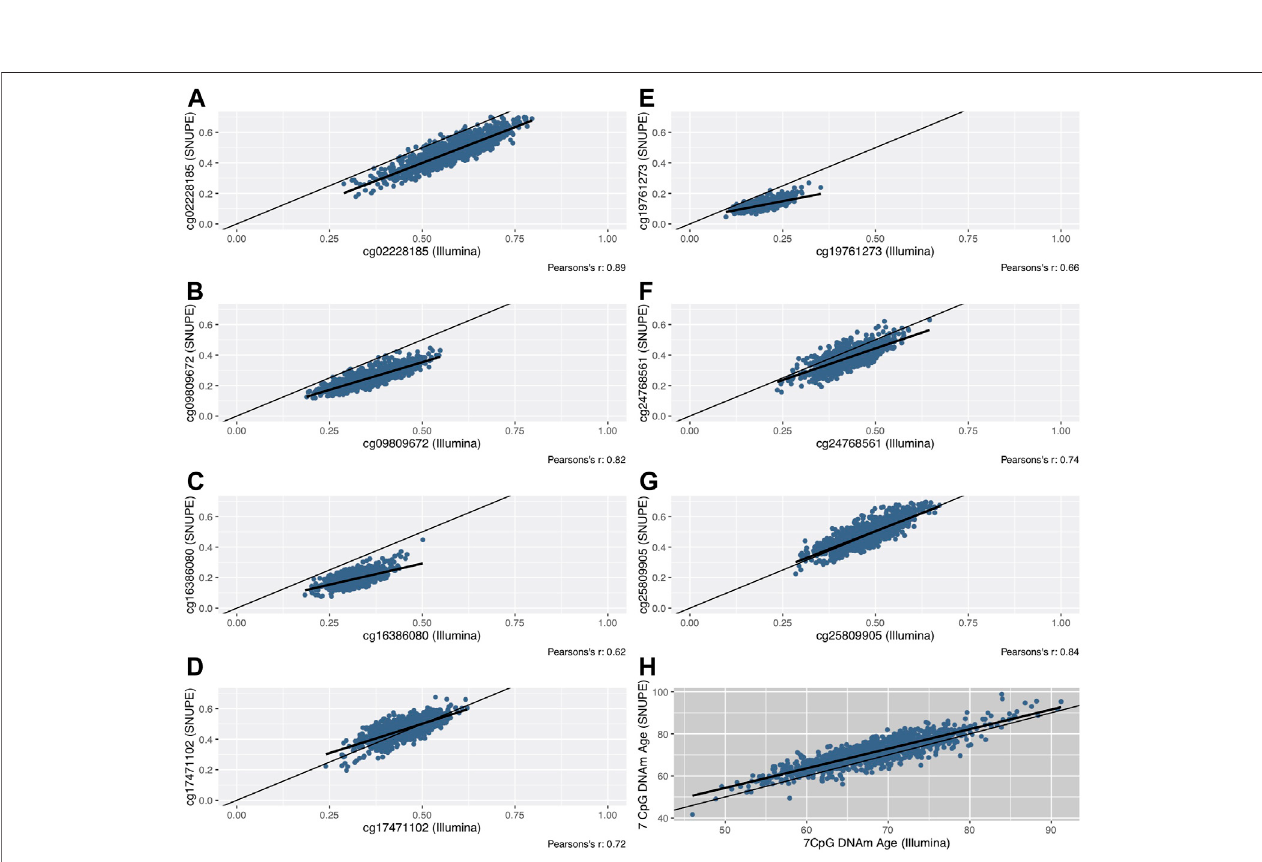
FIGURE 2 | Scatterplots of the methylation fraction of seven CpG sites that were measured with the SNuPE and EPIC array (Illumina) method (A – G) . The line of equality (thin) and the regression line (bold) are displayed. The DNAm age, that was calculated with the 7 CpG clock ( “ BII7 ” formula) is shown in scatterplot (H) .